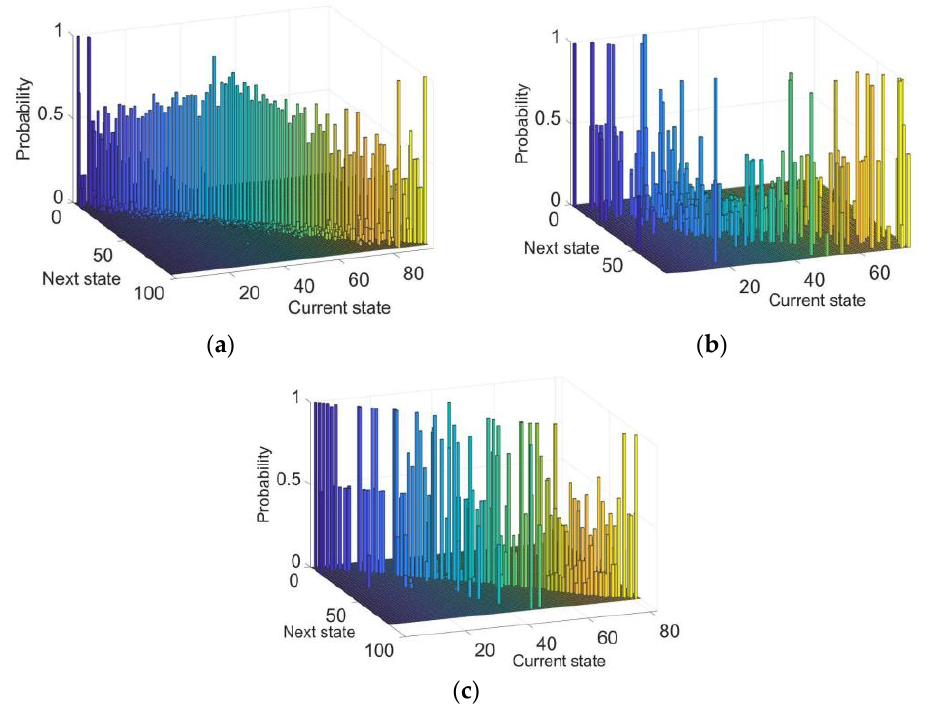
Figure 4. ( a ) TPM of UDDS. ( b ) TPM of NYCC. ( c ) TPM of NEDC.